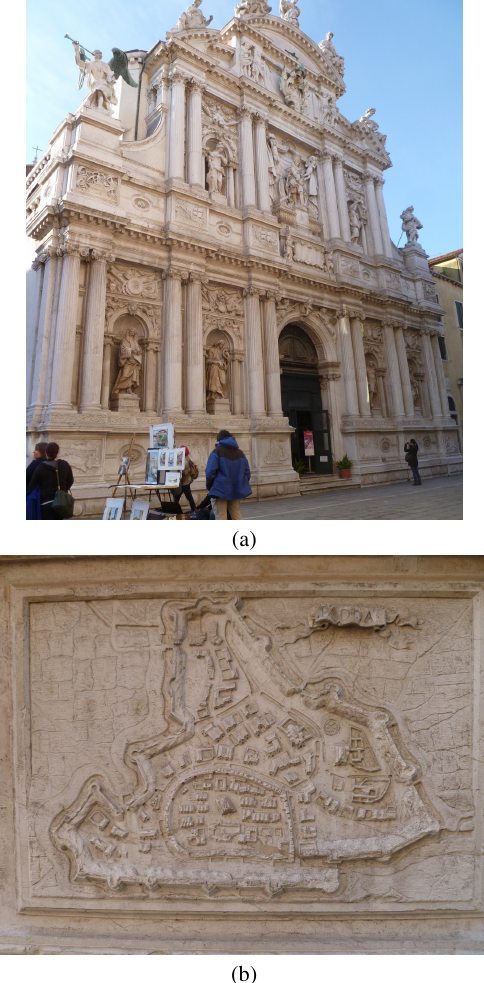
Figure 1. (a) Fac¸ade of Santa Maria del Giglio, Venice, Italy. (b) Low relied of the walls of Padova (Italy), on Santa Maria del Giglio fac¸ade.